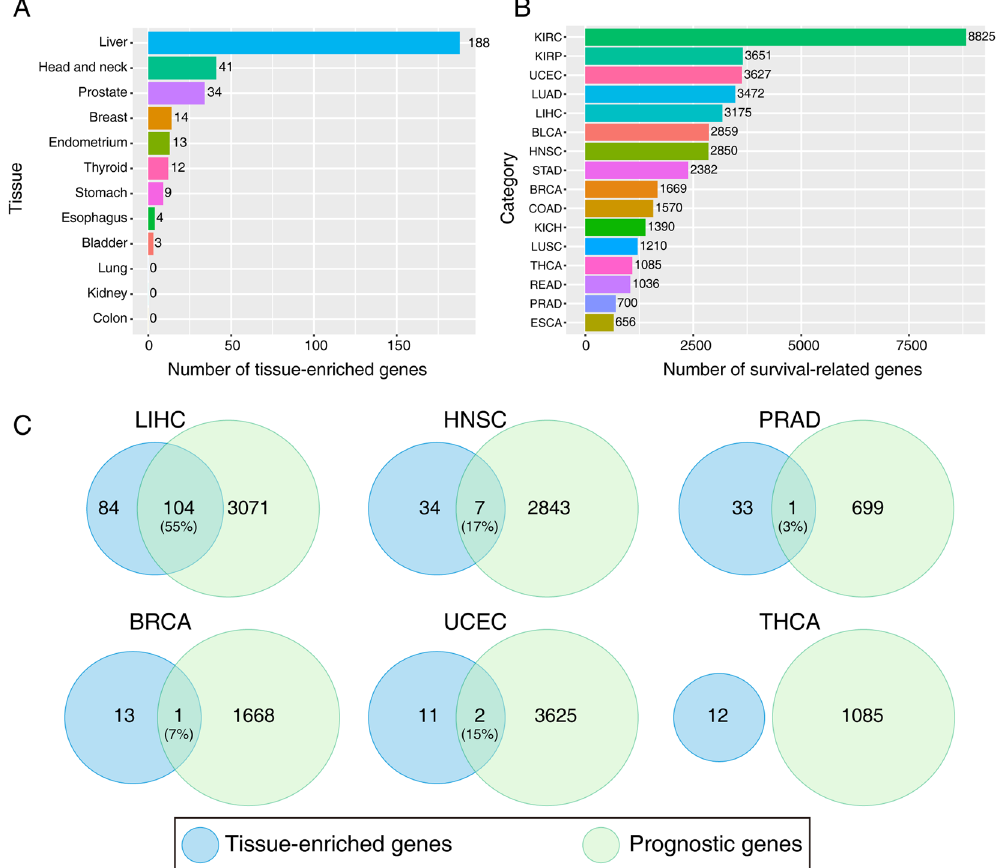
Figure 2. Identification of tissue-enriched genes and prognostic genes. ( A ) Numbers of tissue-enriched genes in the 12 non-tumor tissue types. ( B ) Numbers of survival-related genes in the 16 cancer types. Genes with statistically significant differences (p < 0.05) by the Log-rank test were considered as survival-related genes with a median as cut-off value. ( C ) Venn diagrams showing number of tissue-enriched genes and prognostic genes and their overlap in different cancer types. The percentage of prognostic genes in liver-enriched genes is shown in